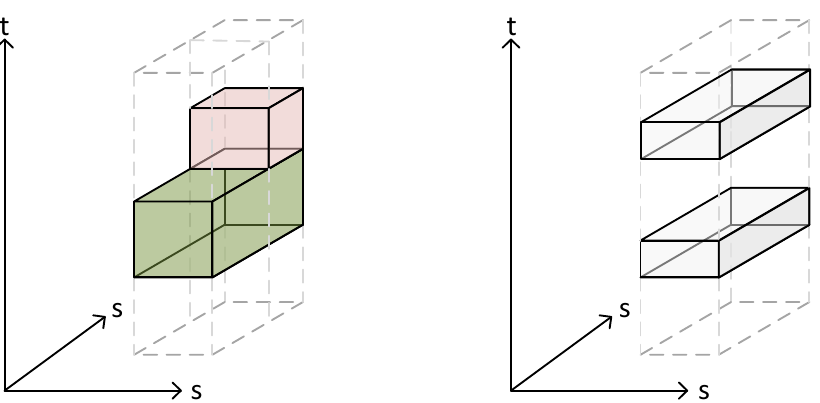
Figure 4. The temporal evolution of workspaces relative to the organization of a scientific conference. The left side represents a reduction of the space in which the conference is organized, e.g., a workshop directly following the conference but which only occupies one part of the building. The right side represents the temporal succession of a conference located in the same space.